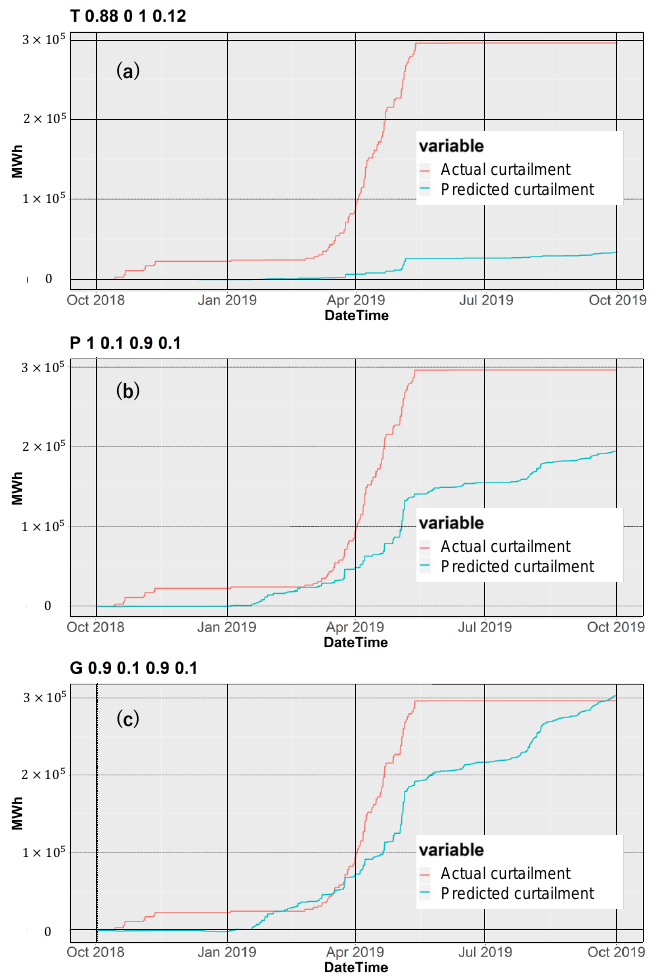
Figure A1. ( a ) Calibration result T0.88,0,1,0.12; ( b ) calibration result P1,0.1,0.9,0.1; and ( c ) calibration result G0.9,0.1,0.9,0.1. The red lines indicate the actual cumulative curtailments and the blue lines represent the predicted curtailments. Energies 2020 , 13 , x FOR PEER REVIEW